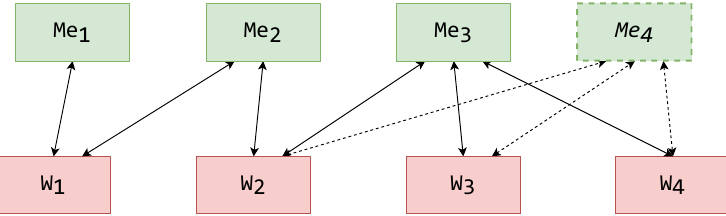
Figure 14. Scenario 1 outcome on a one-layer mediator MW